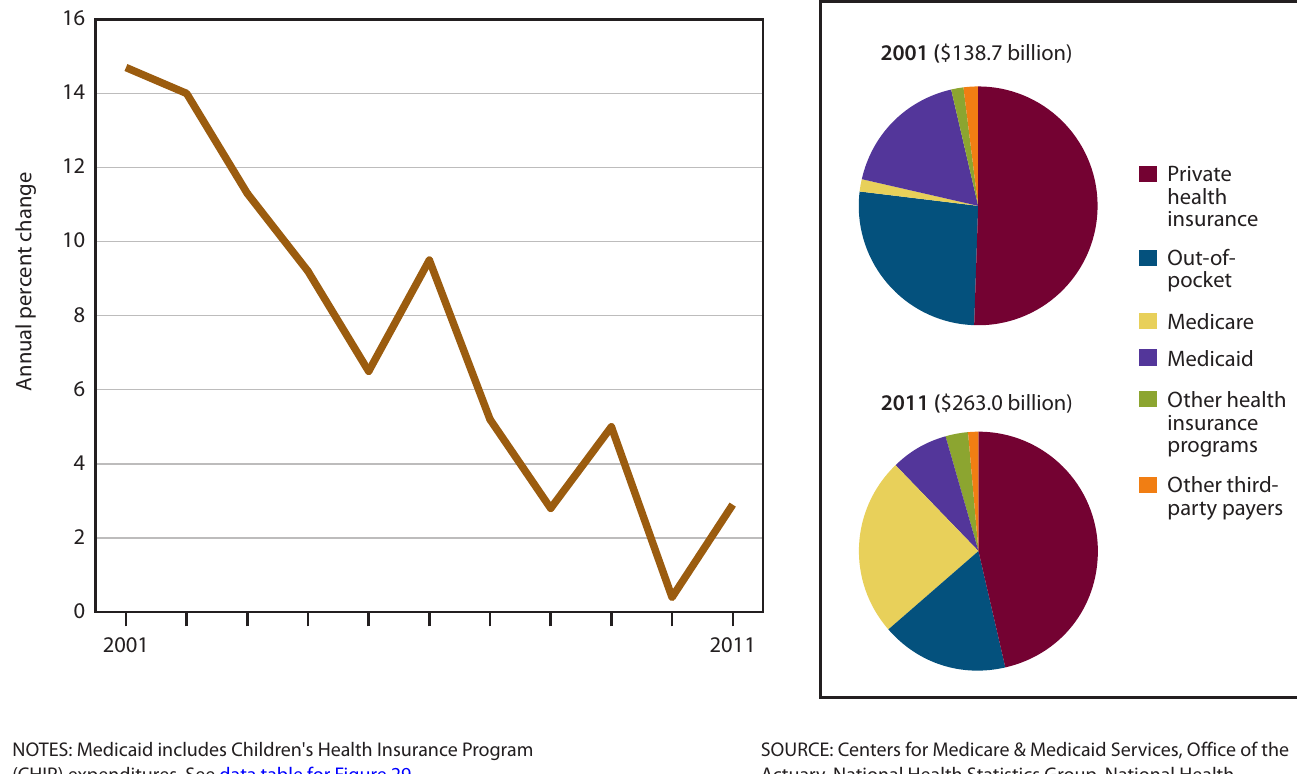
Figure 29. Retail prescription drug expenditures, annual percent change, and spending by payer: United